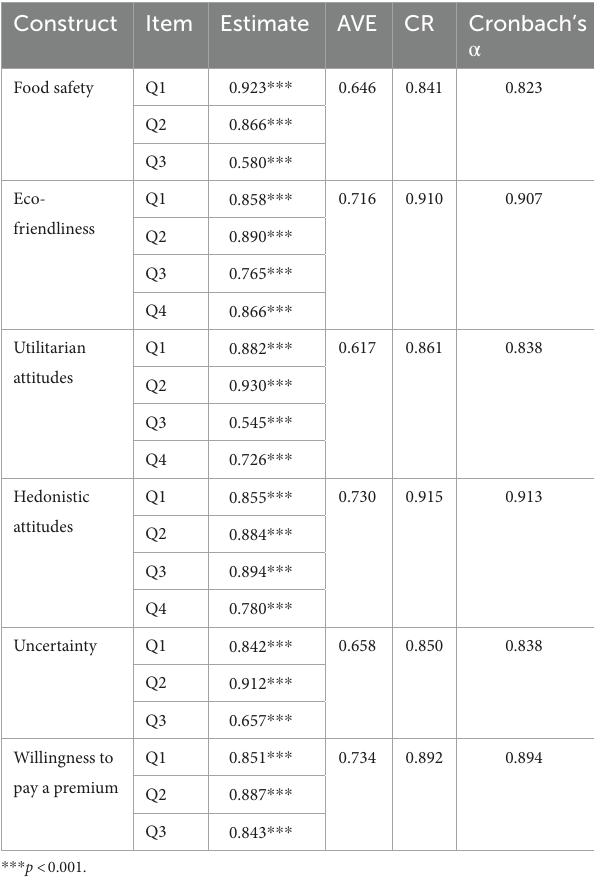
TABLE 3 Confirmatory factor analysis